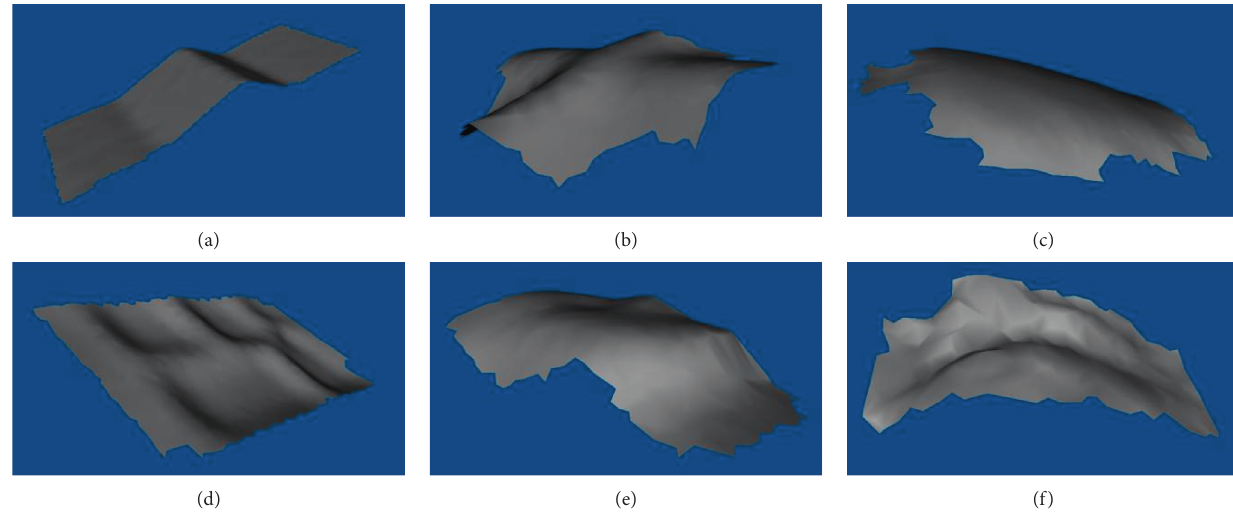
Figure 17: 3D reconstruction results for (a) four-stairs, (b) polygon, (c) yellow bottle, (d) tableware, (e) head model, and (f) mouth model.